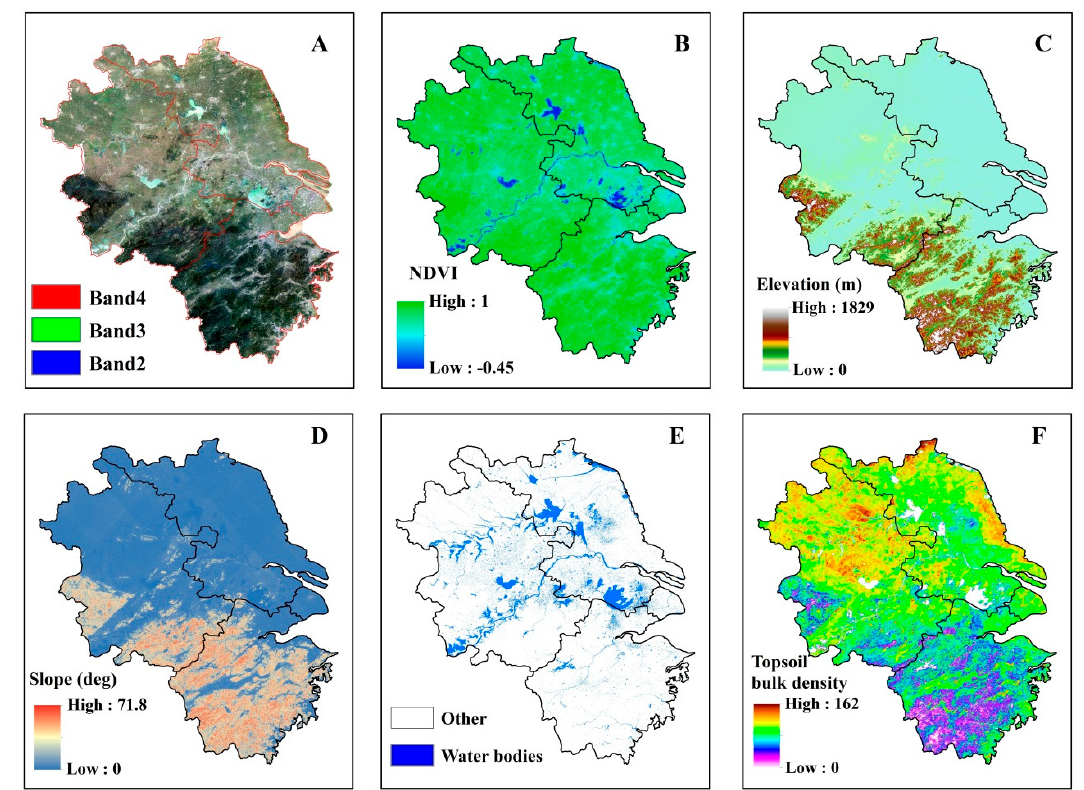
Figure 2. Datasets used in the study: ( A ) Median of the 2015 Landsat 8 Operational Land Imager (OLI) (4/3/2 bands), ( B ) Max Normalized Difference Vegetation Index (NDVI), ( C , D ) Shuttle Radar Topography Mission (SRTM) Digital Elevation Data, ( E ) European Commission’s Joint Research Centre (JRC) Yearly Water Classification History, and ( F ) OpenLandMap SoilGrids.